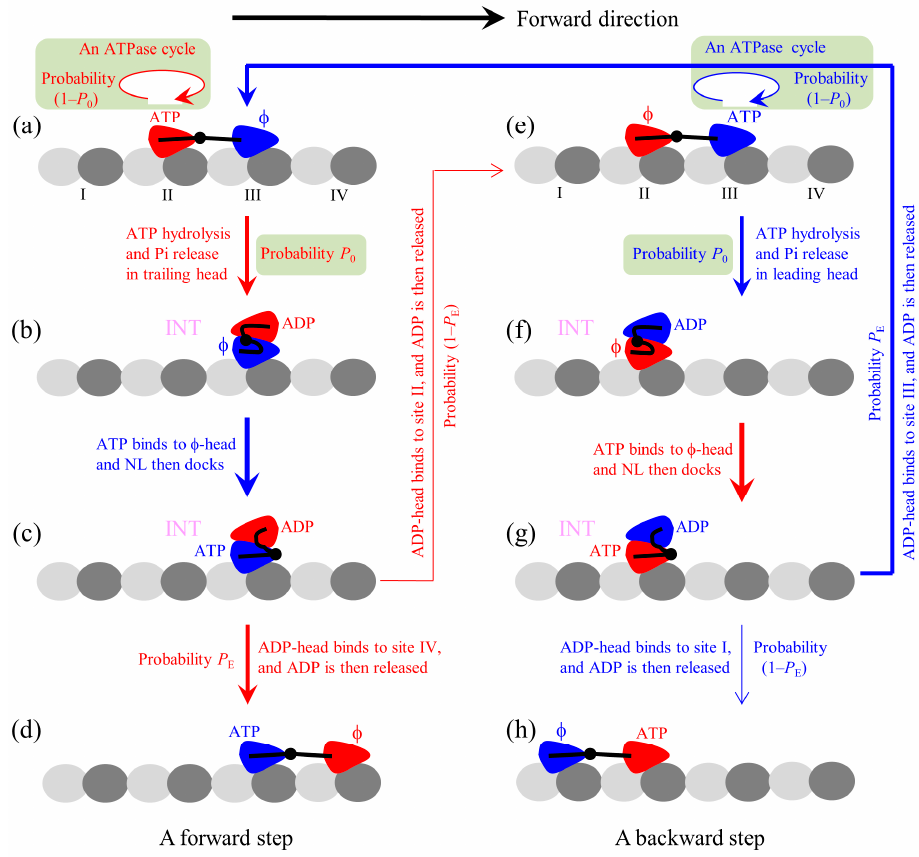
Figure 1. The model of stepping of kinesin dimer at low ATP concentrations. ( a – h ) The pathway for the chemomechanical coupling (see text for detailed description). The thickness of the arrow represents the magnitude of the transition probability under no external force.